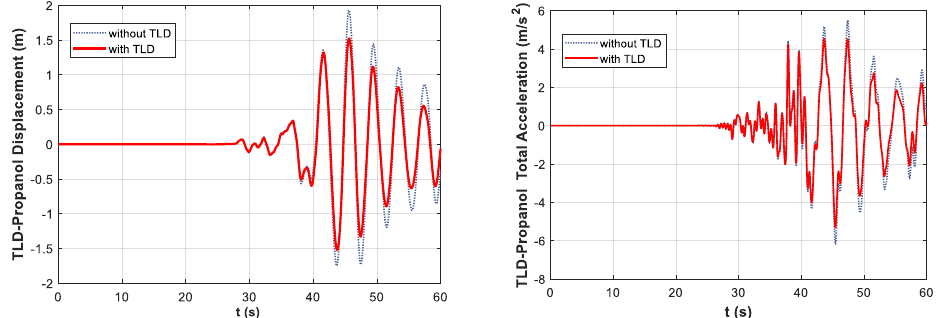
Figure 18. AHS optimization of the 40-story structure displacement–time and total acceleration–time graphs in the CHICHI/CHY101-N earthquake record for TLD–seawater.